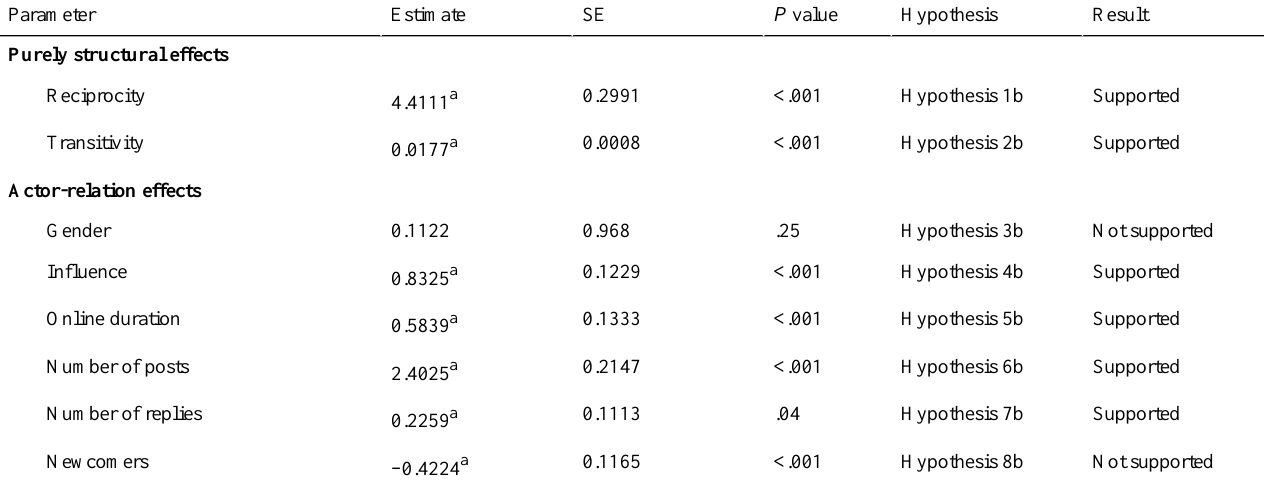
Table 2. Exponential random graph model estimates for the emotional support